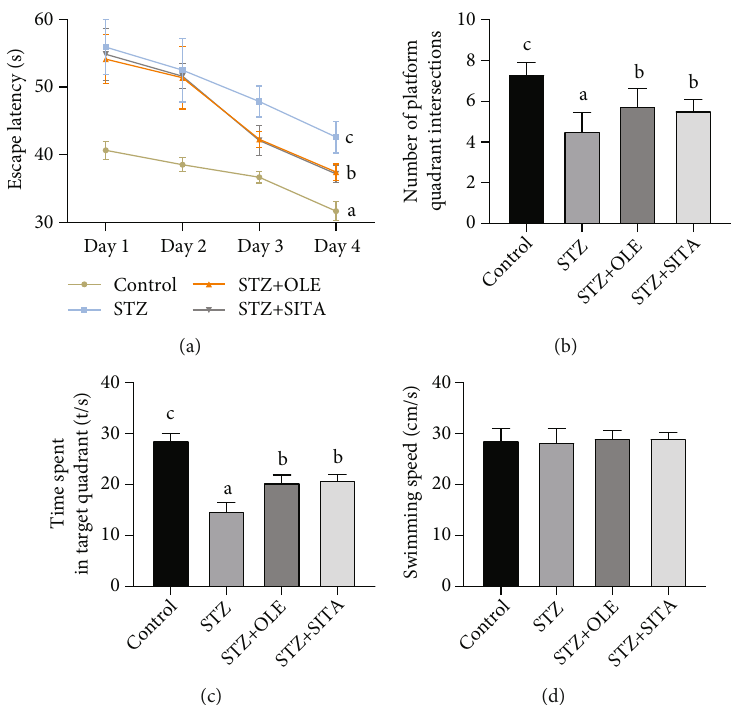
Figure 2: E ff ects of oleuropein on spatial learning and memory in diabetic rats. (a) The escape latency of rats in the Morris water maze on days 1, 2, 3, and 4. (b) The number of crossing intersections of the platform quadrant in Morris water maze test. (c) The time spent by rats in the target quadrant in the Morris water maze test. (d) The swimming speed of the rat in the Morris water maze test. Each set contains data from 3 samples tested independently; LSD test was used for multiple comparisons. ∗∗ p < 0 : 05 vs. control group and ## p < 0 : 05 vs. STZ